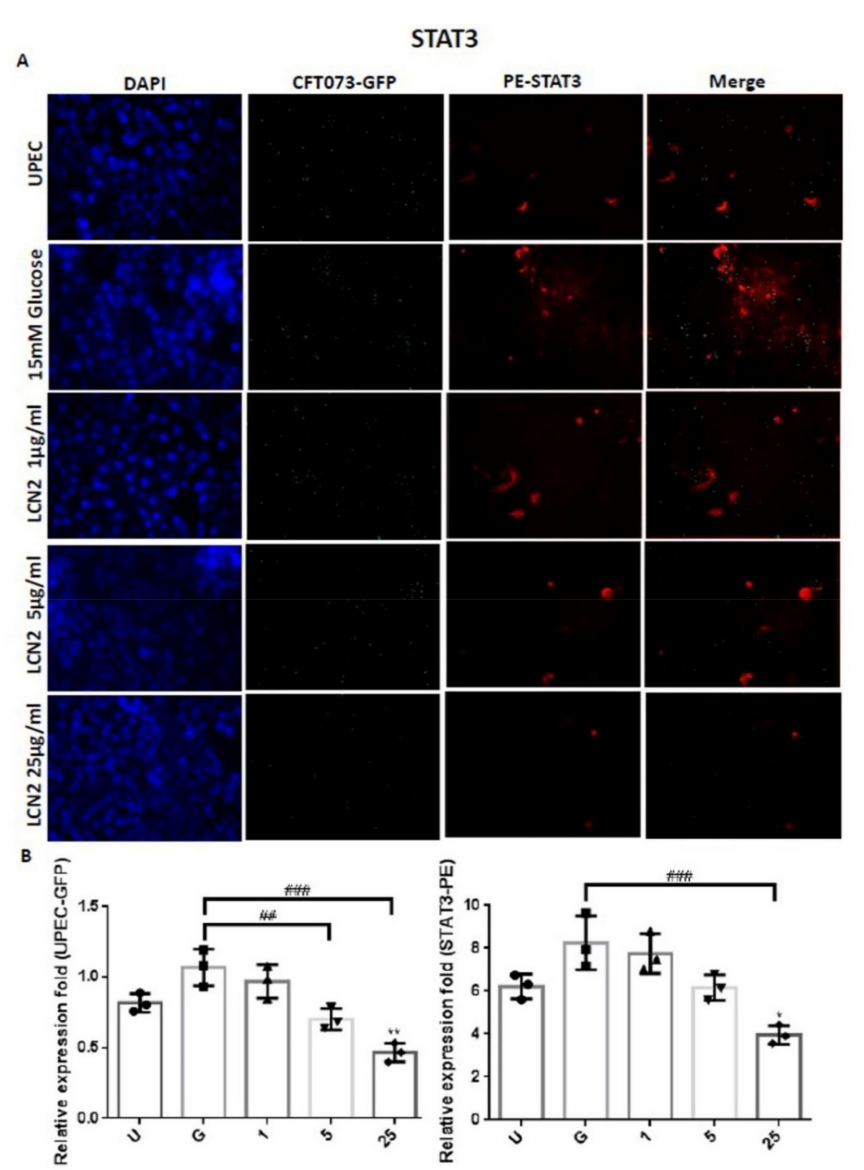
Figure 3. LCN2 decreased UPEC infections and STAT3 expression in bladder cells. SV-HUC-1 cells were first pretreated with 15 mM glucose, followed by treatment with different concentrations of LCN2 (1, 5, and 25 µ g/mL) for 24 h and infection with pGFP-UPEC (MOI of 1:100) for 4 h, as described in the text. The definitions of the letters on the X axis: U, UPEC infection alone; G, with 15 mM glucose pretreatment alone. GFP-UPEC and PE-STAT3 expression in SV-HUC-1 cells, for 4 h postinfection, were ( A ) observed by fluorescence microscopy and ( B ) measured using ImageJ software. Cells infected with UPEC alone were used as positive controls. The pictures shown are representative of typical results. DAPI was used to count the number of cells and as a standard for calculating the fluorescence expression ratios of cells. Cell images were captured using a microscope (Leica) at 100 × magnification. The data are expressed as means ± SDs from three separate experiments. An analysis of variance was used to evaluate differences between various treatment groups and controls. Statistical differences between groups were determined using the Mann–Whitney U Student’s t -test. Statistical significance was set at p < 0.05. * p < 0.05, ** p < 0.01 compared to the positive control groups. ## p < 0.01, ### p < 0.001 for comparisons between two